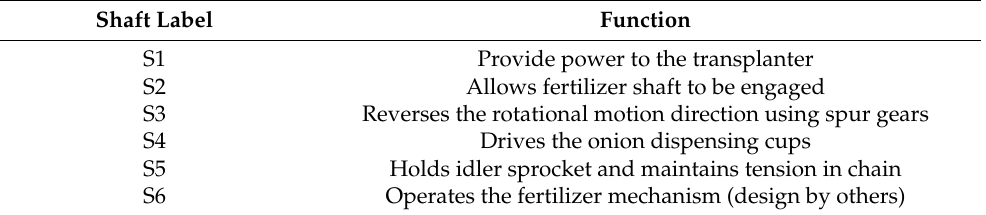
Figure 9. Powertrain schematic. Table 2. Shaft labels and descriptions.